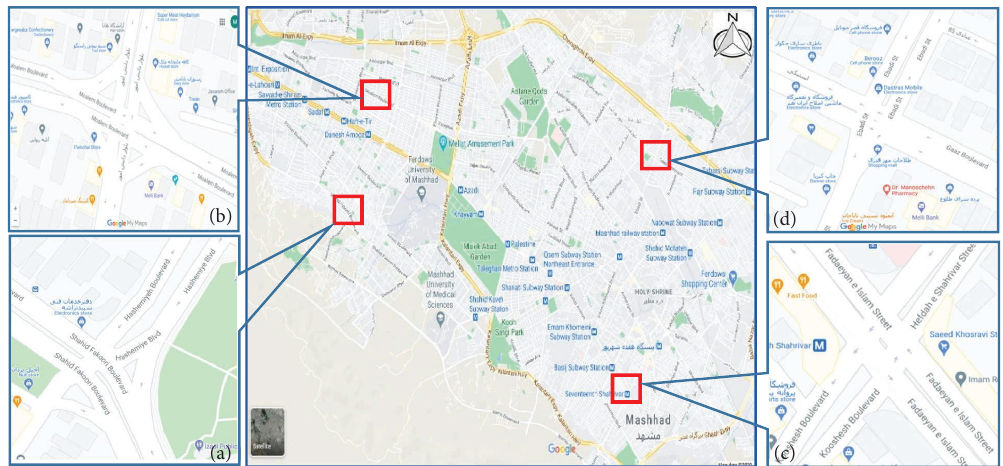
Figure 3: Schematic location of intersections under study. (a) Hashemieh-Fakuri. (b) Moallem-Daneshamooz. (c) Kooshesh-Fadaiyan. (d) Gaz-Ebadi. Table 2: Summary of the data observed at the four study